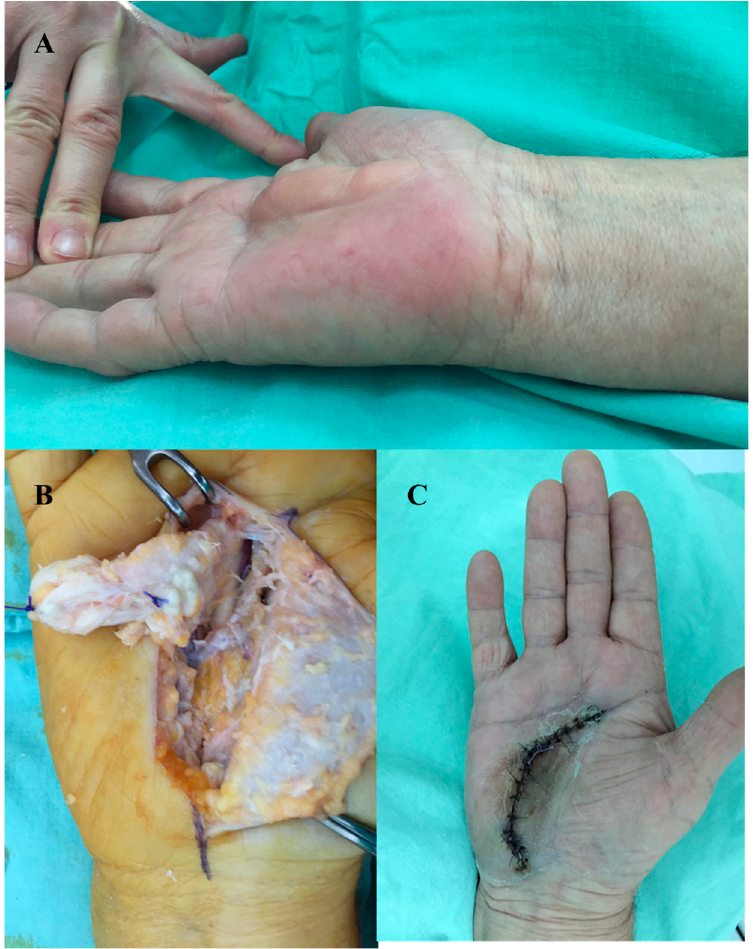
Figure 11. Epidermal inclusion cyst ( A ) preoperative aspect, ( B ) intraoperative aspect, ( C ) postoperative aspect (ten days after surgery) .